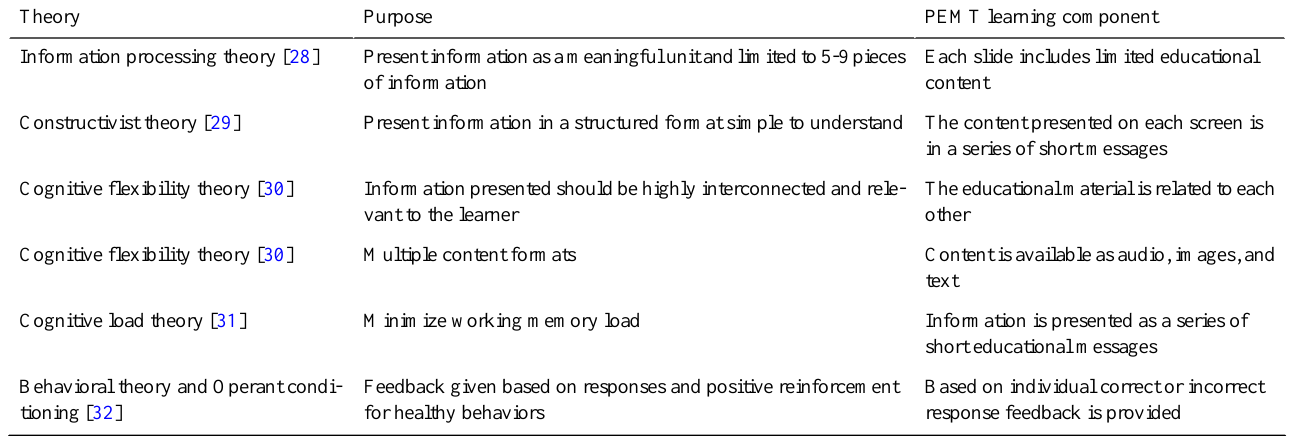
Table 1. Modify PEMT to adapt to computer mediated breastfeeding educational program.